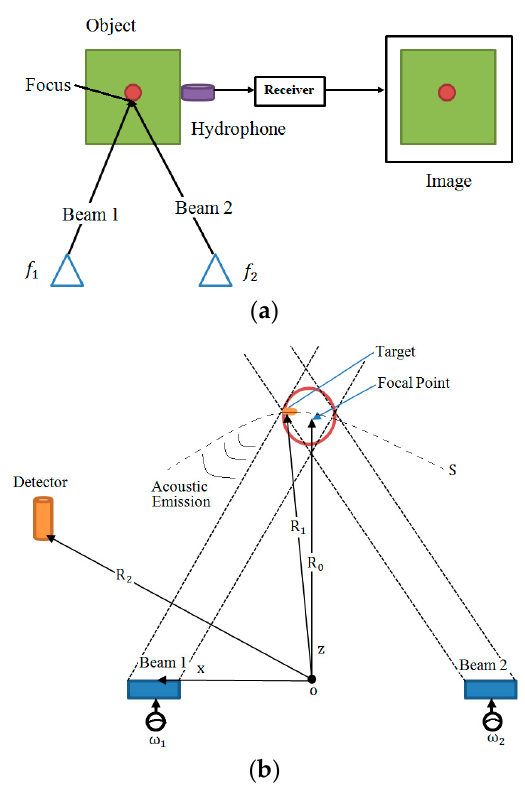
Figure 1. ( a ) Diagram of a Vibro-Acoustography (VA) imaging system; ( b ) The plane wave model for VA beamforming.